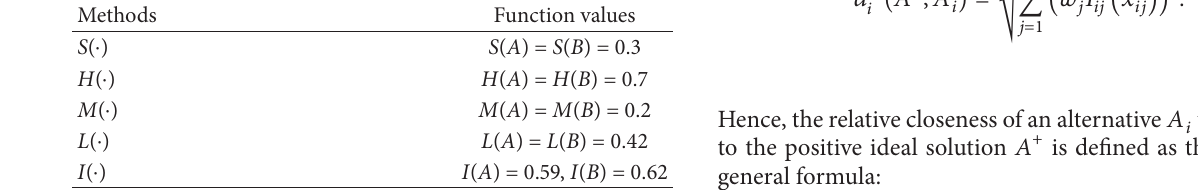
Table 1: Function values of various methods.